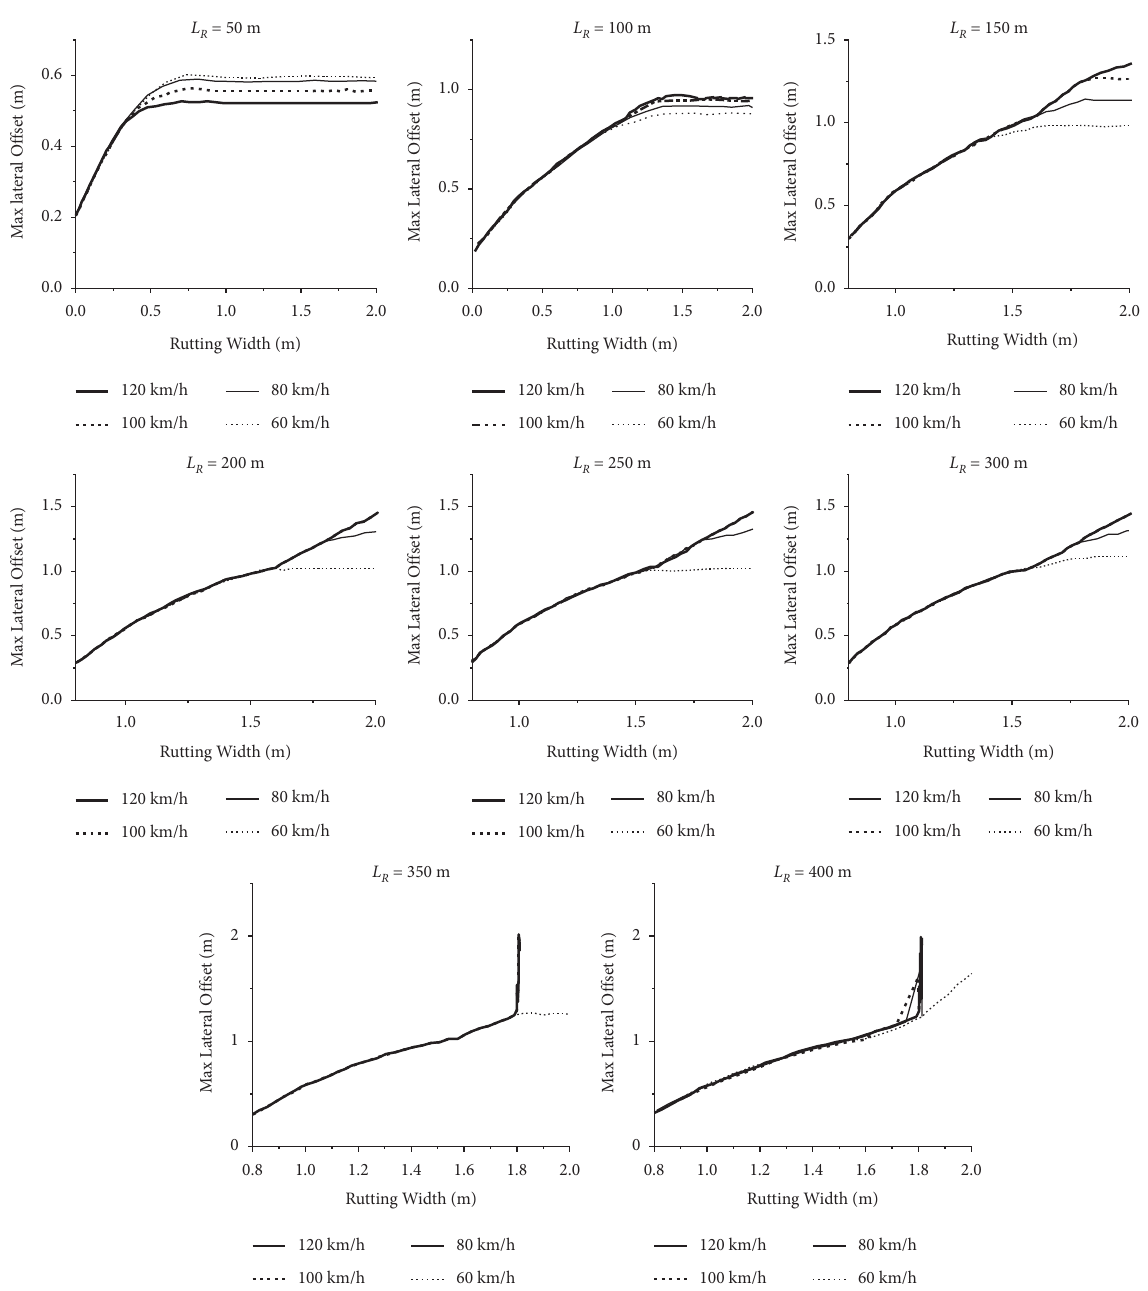
� 1.025mm). R refers to rutting length; L m